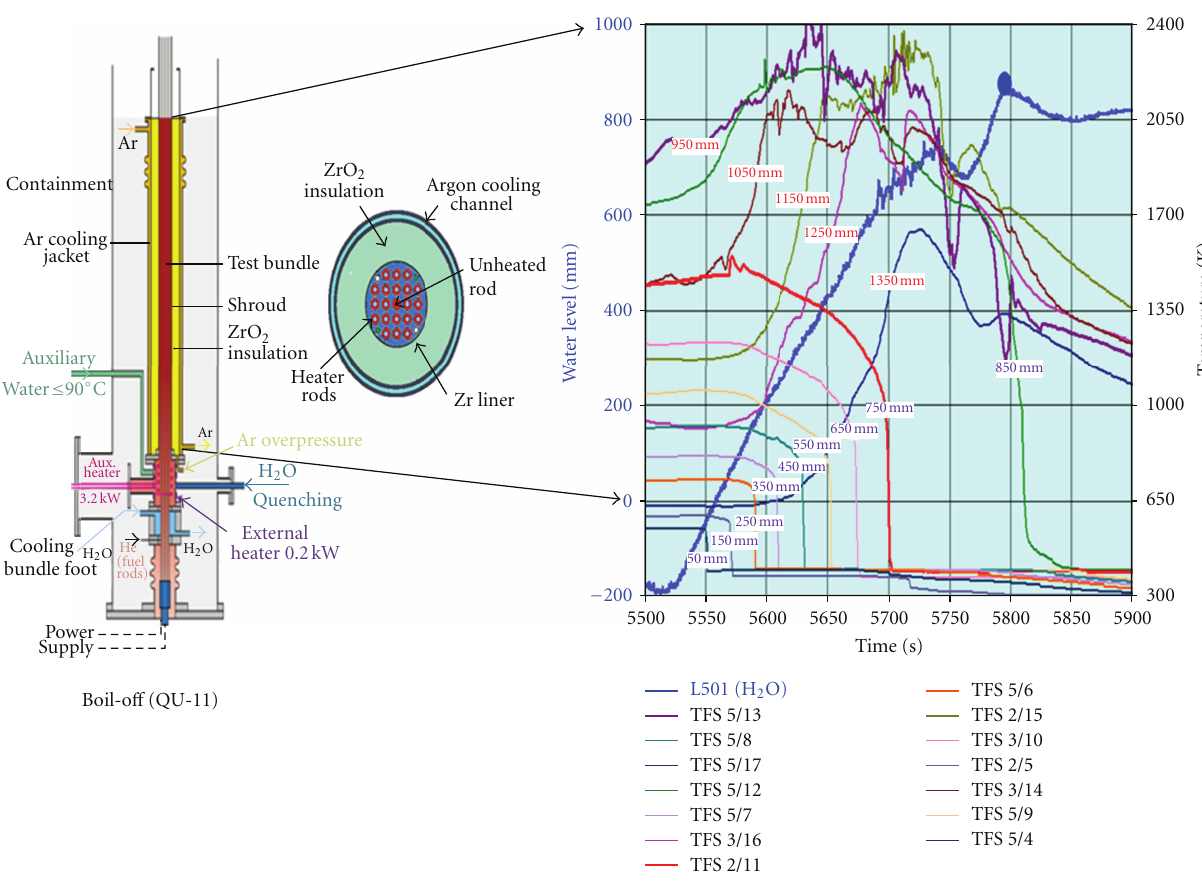
Fukushima Daiichi cores, vessels, and containments